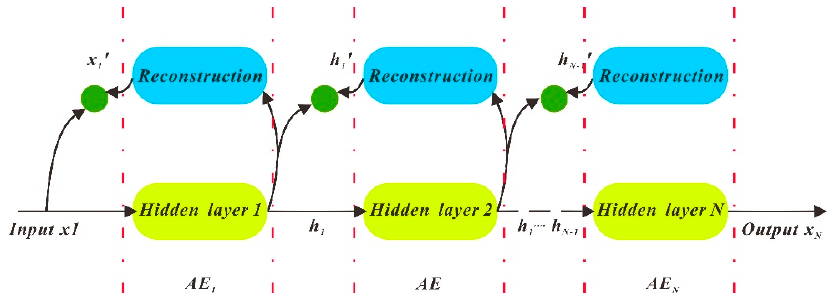
Figure 10. Stacked Autoencoder (SAE) structure diagram.